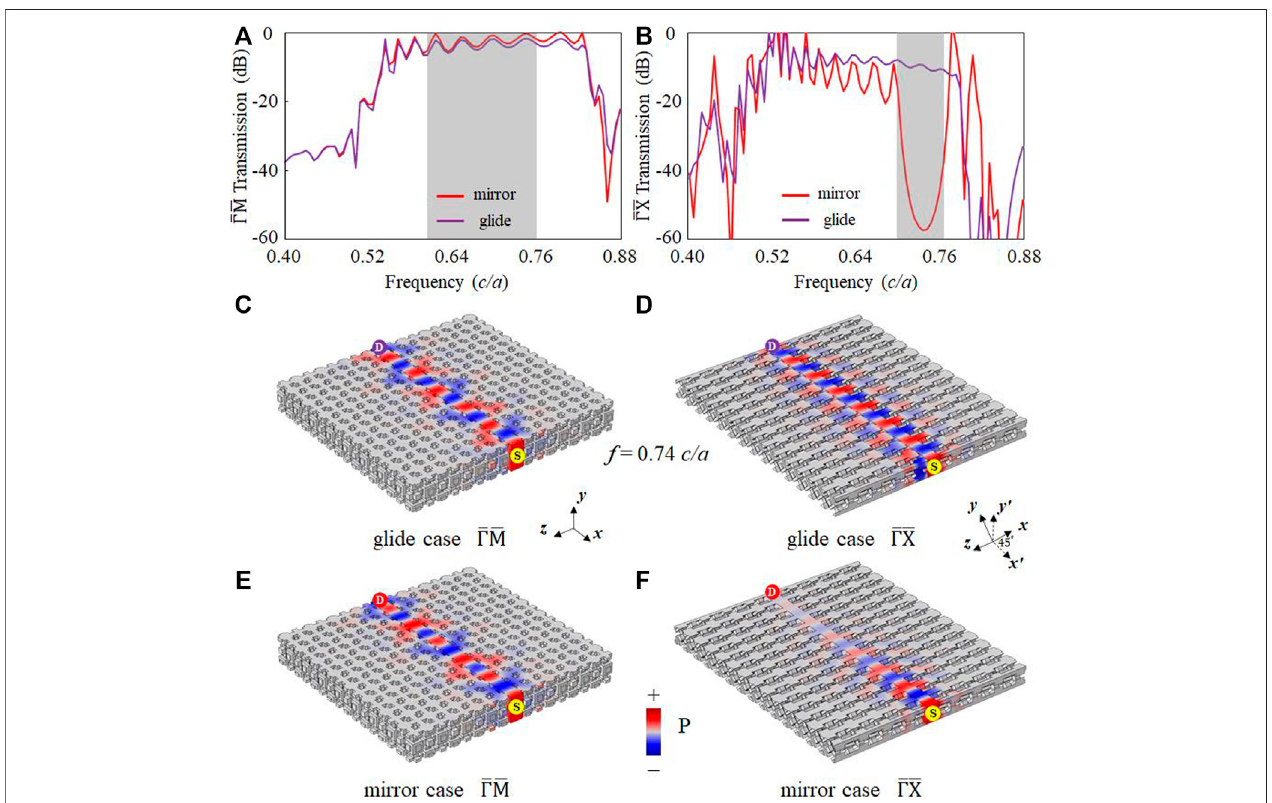
FIGURE 5 | Acoustic transmission spectra. (A) Γ (cid:2) M-direction transmission spectra on mirror- and glide-symmetry domain walls. The shadow area represents the complete bulk bandgap. (B) (cid:2) Γ (cid:2) X-direction transmission spectra, where the shadow area represents the directional surface bandgap of the mirror case. (C-F) Acoustic fi eld distributions at a frequency of 0.74 c/a